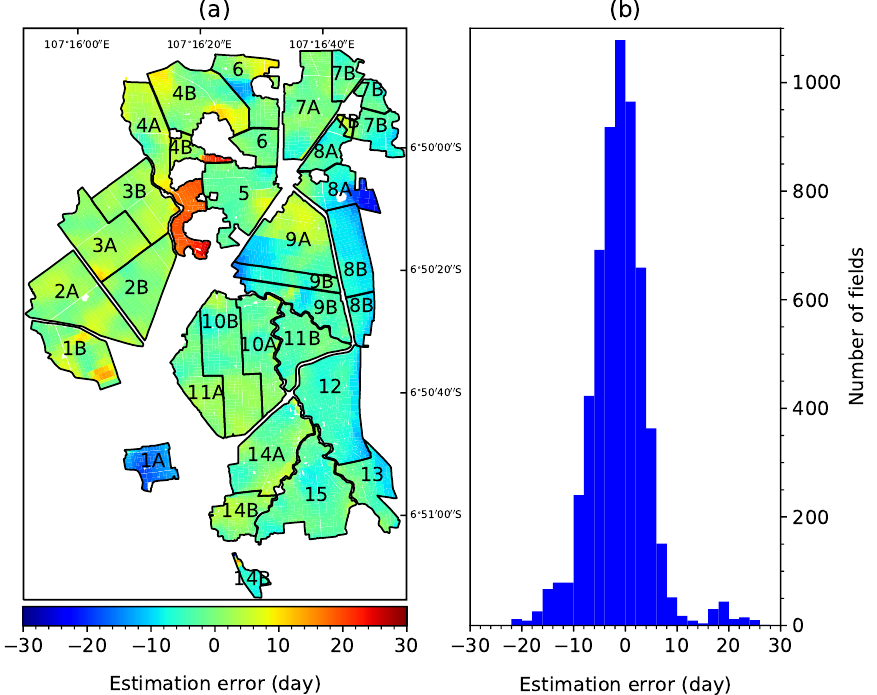
Figure 6. Map ( a ) and histogram ( b ) of transplanting date estimation errors (first crop in the dry season of